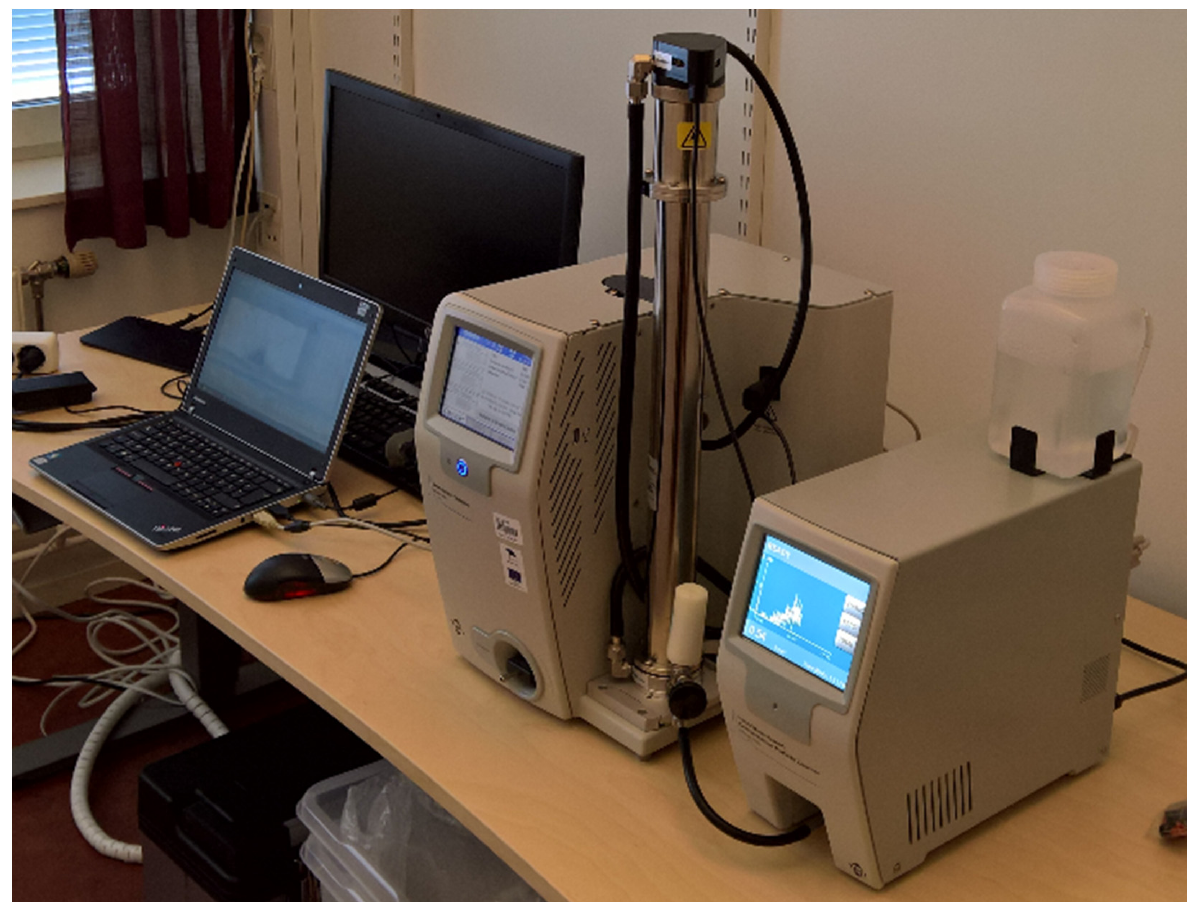
Figure 2. Measurement of nanoparticles indoors with SMPS 3938.